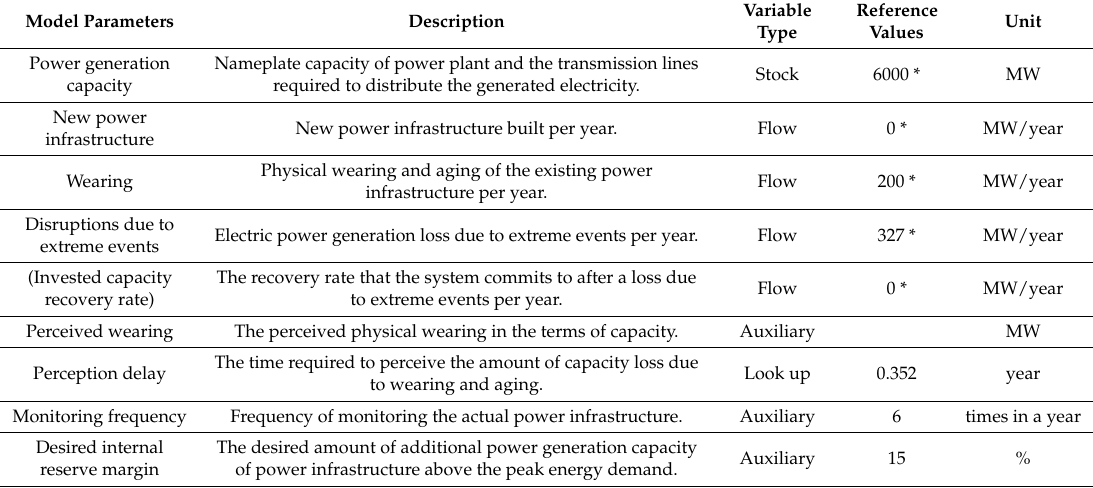
Table 1. Summary of the model parameters. Note that only constant values of the parameters are reported; when no value is reported, it means that it is a dynamic